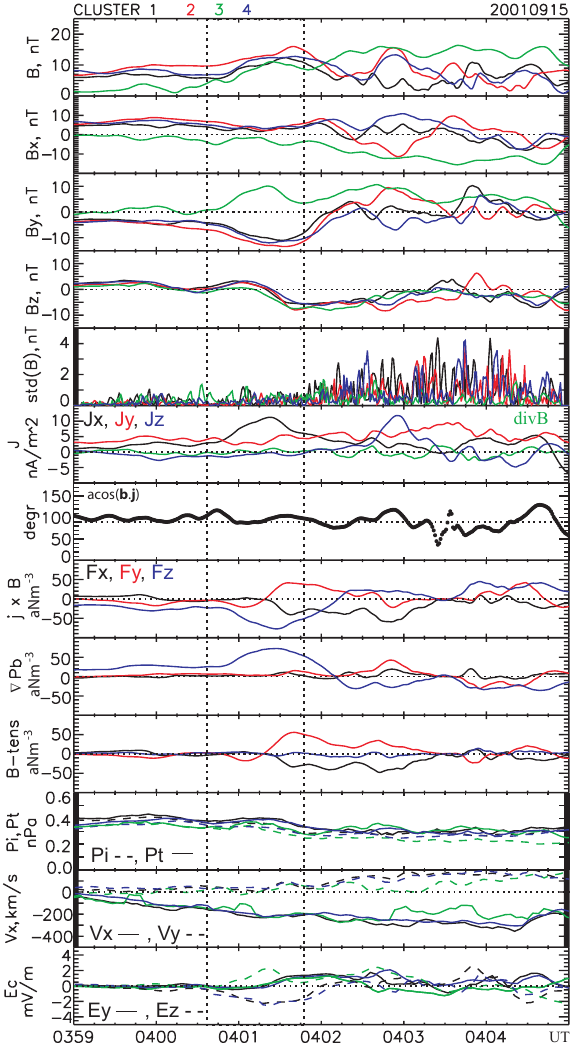
Fig. 12. Cluster observation during interval C : The same format as in Fig.